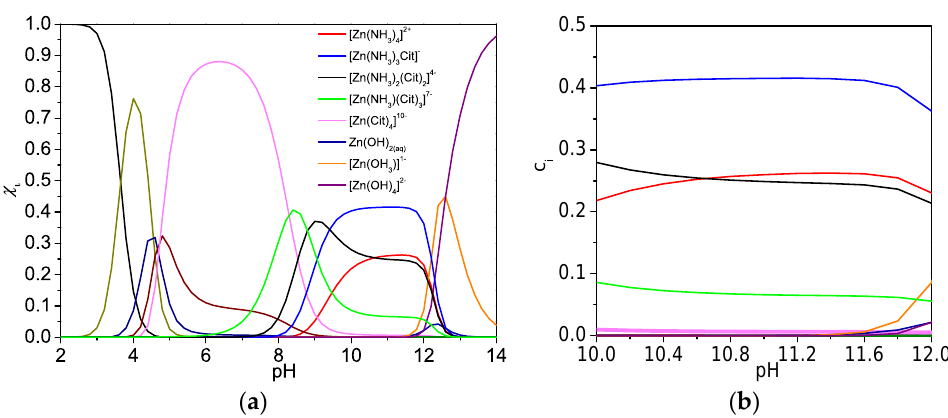
Figure 3. Species distribution diagram for Zn(O;OH)S synthesized by the CBD method under experimental conditions. ( a ) pH range 2 – 14. ( b ) zoom range pH 10 – 12. Inside figure, Cit represents citrate anion ([C 6 H 5 O 7 ] 3 − ). ( x i ) represents fraction molar for each species at equilibrium.